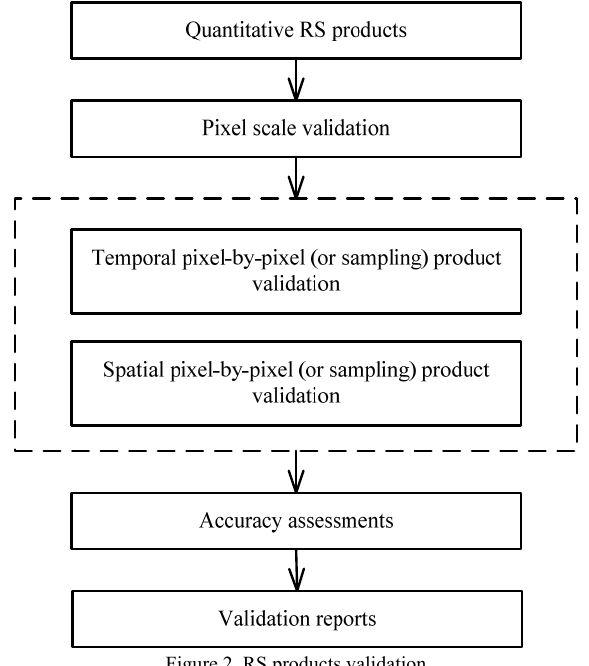
Figure 2. RS products